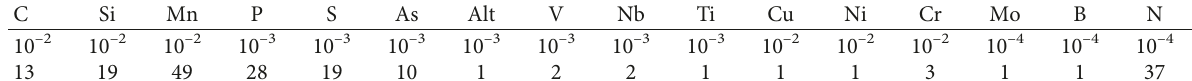
Table 1: Element composition of Q235A specimen.